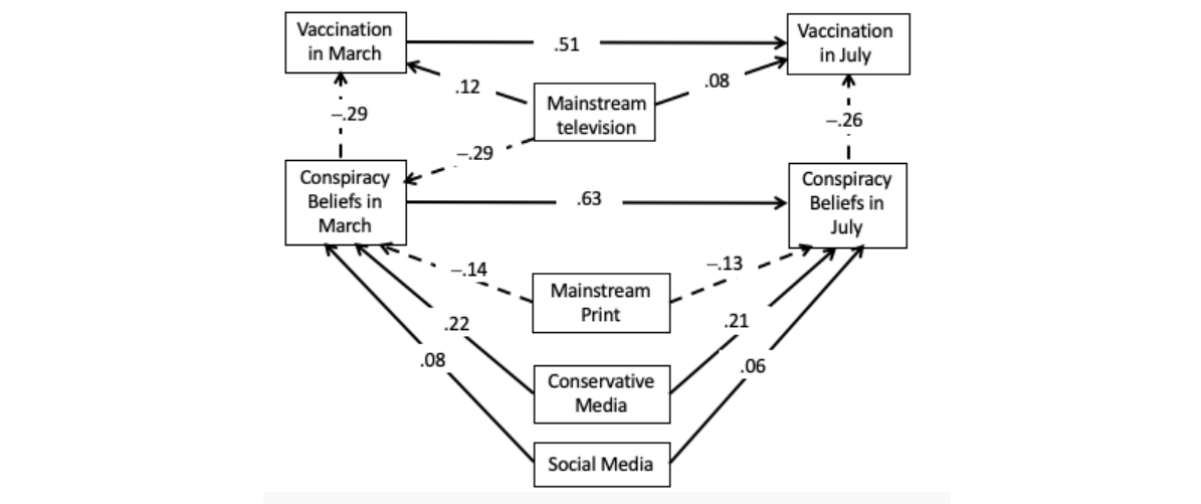
Figure 3. Standardized relations between media use in March and conspiracy beliefs and vaccine intentions in July. All paths within 99% CIs, except between social media and conspiracy beliefs in March and July, which excluded zero at the 95%